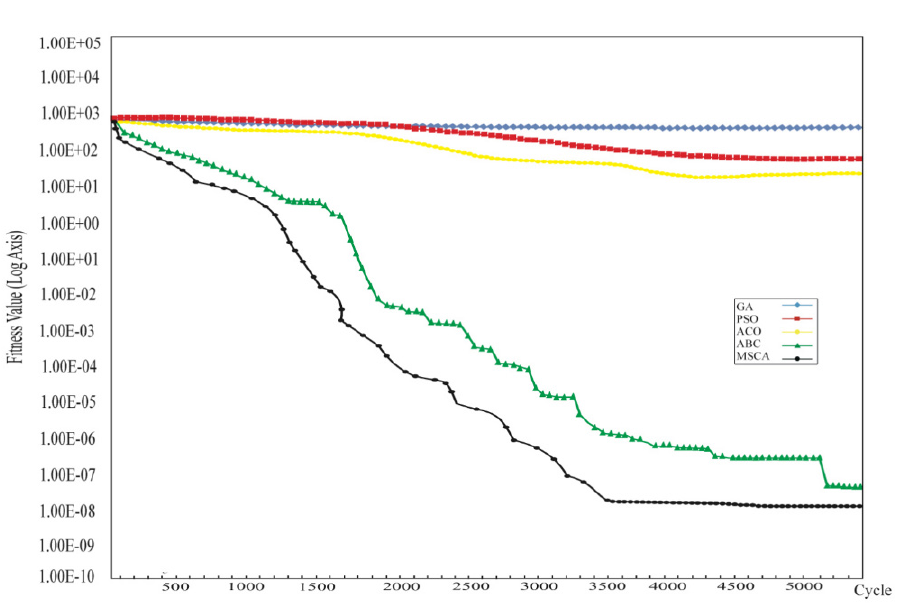
Figure 4. The results of applying different algorithms on Ackley function.